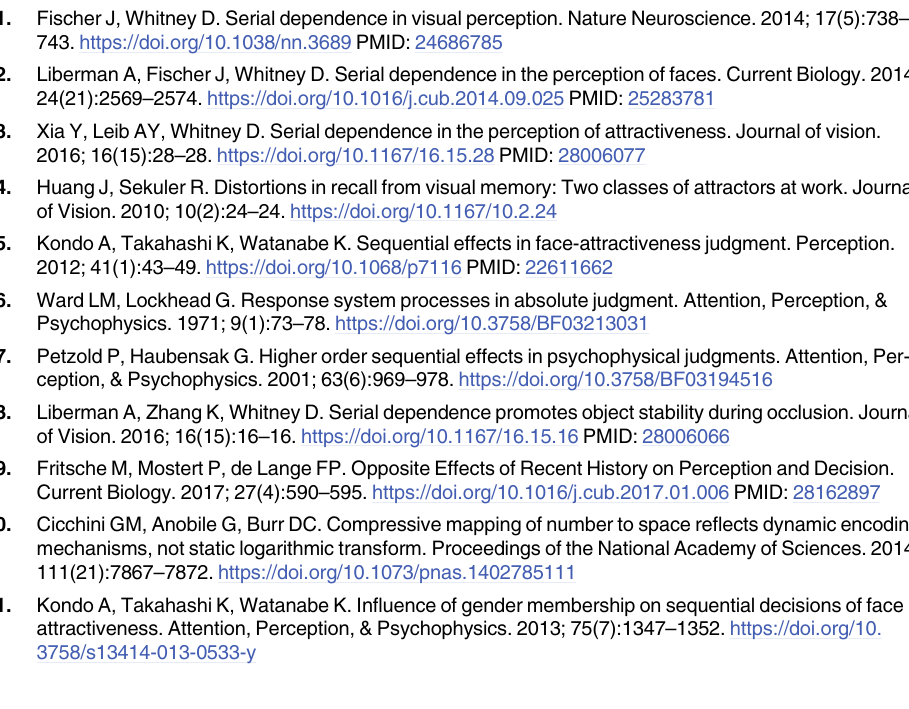
S3 Fig. Results for Model 2 after accounting for adaptation. Peak-to-peak of the DoG fit across the working memory delay. Shading represents bootstrapped 95% confidence intervals. Immediately after stimulus offset (0 s delay), positive serial dependence is already present in responses. The magnitude of this serial dependence does not change as the delay is lengthened to 10 s.